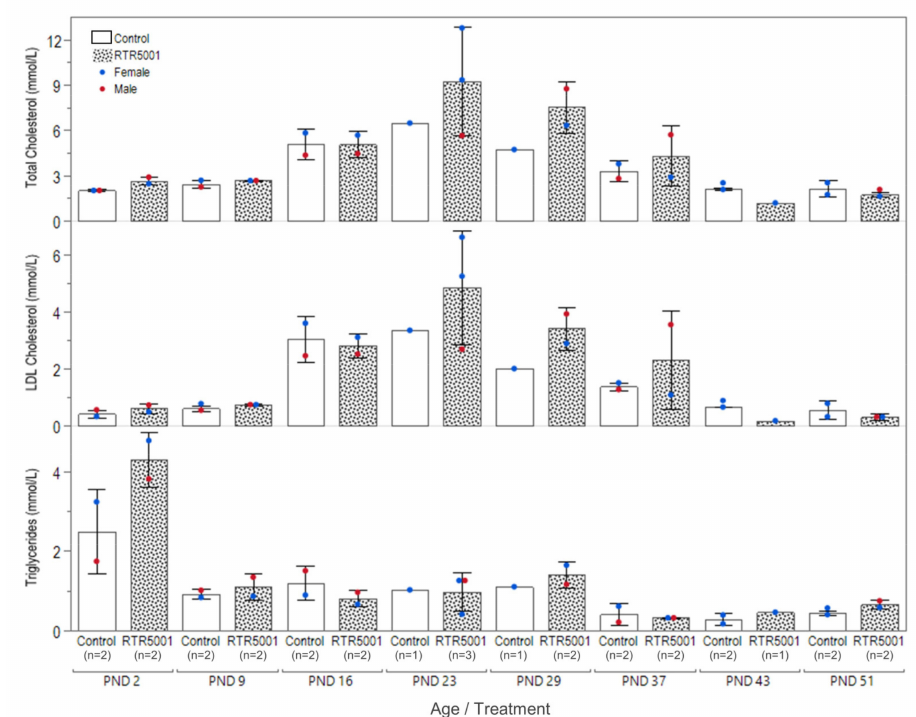
Figure 4. Mean ± SD level of serum total cholesterol, LDL cholesterol, and triglycerides in control and RTR5001-treated minipigs in the different juvenile age groups.